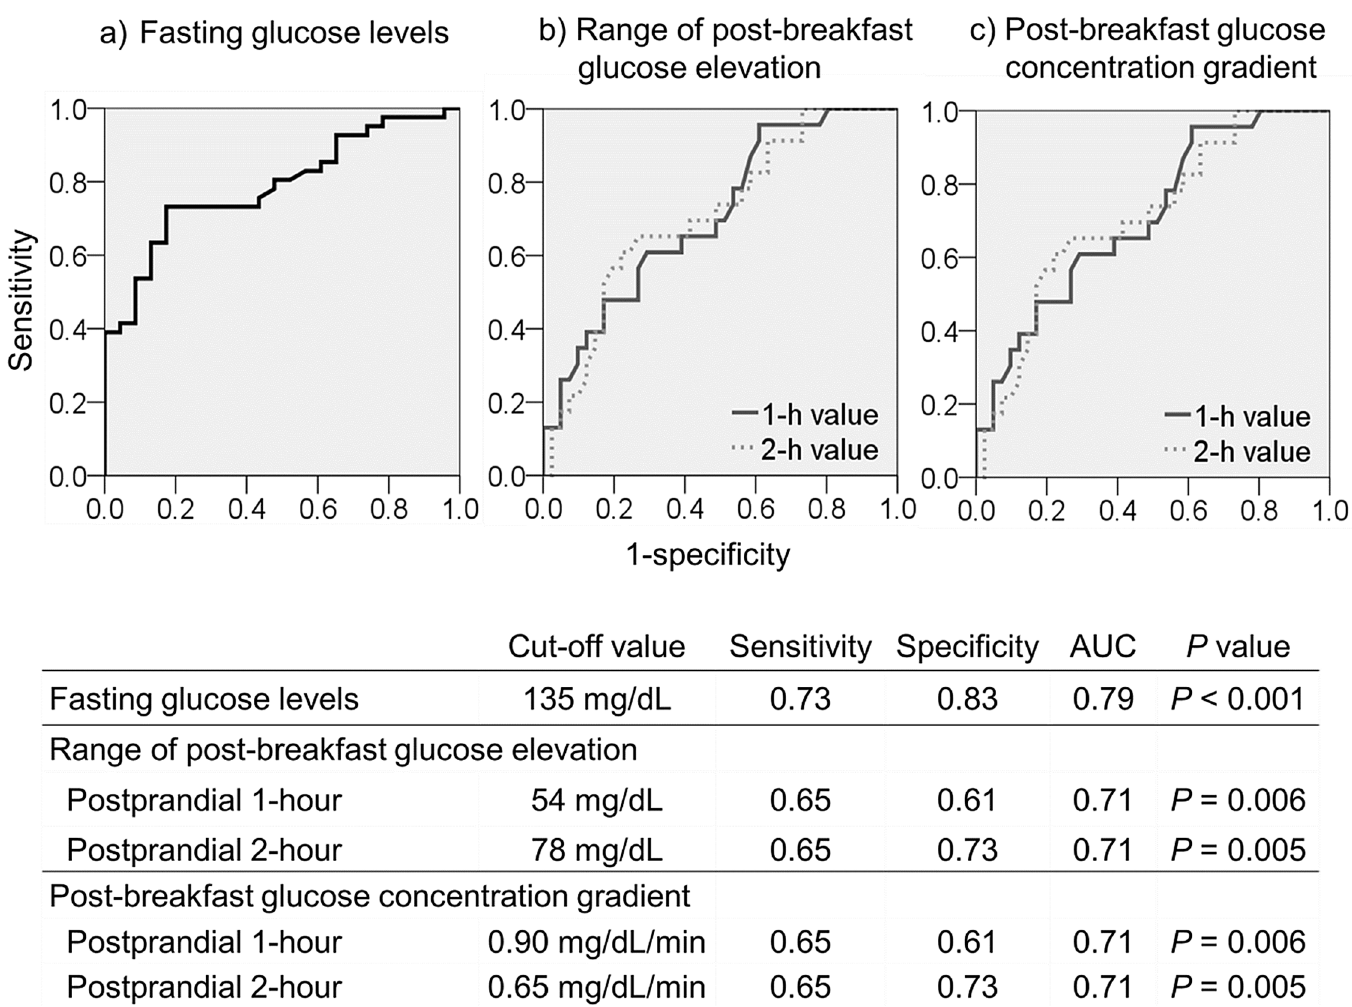
Fig 2. Cut-off Values for Predicting Nocturnal Asymptomatic